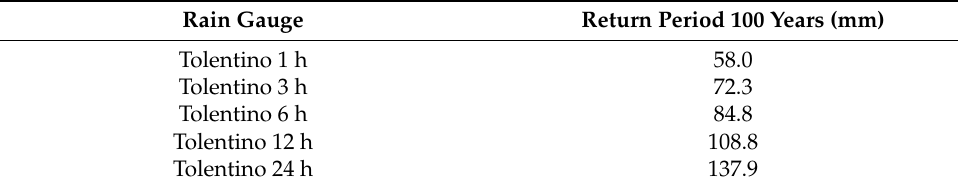
Table 1. Example of calculation of return period 100 years of precipitation for Tolentino rain gauge.